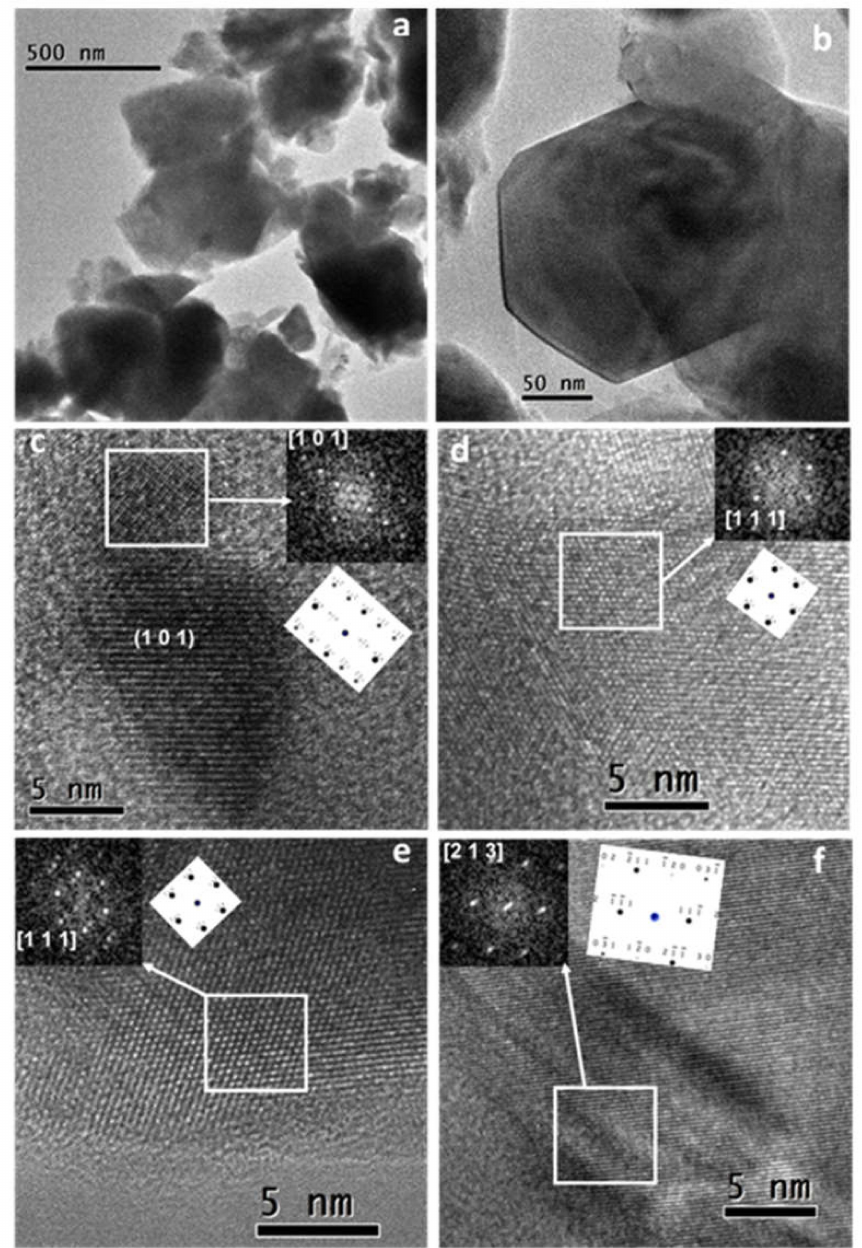
Figure 3. Microstructural results of the LSGM powder sample heated to 1400 ◦ C. ( a , b ) TEM images at low magnification, ( c – f ) HRTEM micrographs, with some white square areas marked and the corresponding fast Fourier transform (FFT), and simulated EDP